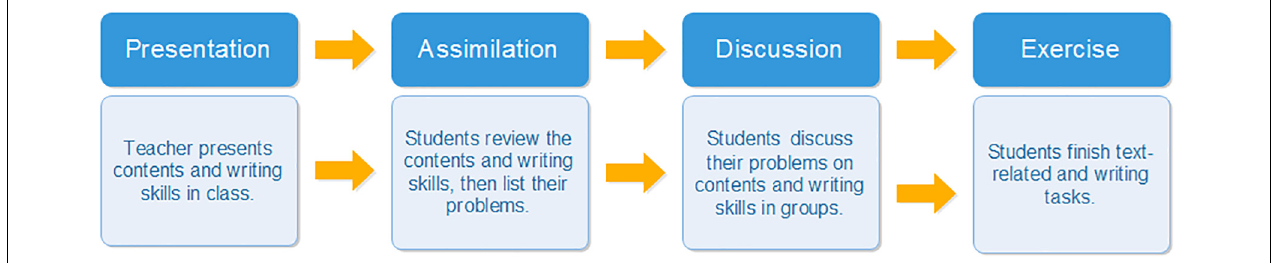
FIGURE 1 | The implementation of the PADE argumentative writing teaching practice.